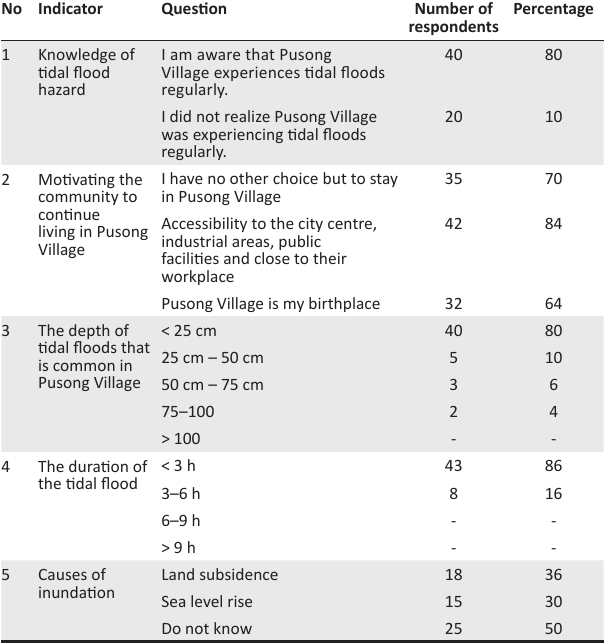
FIGURE 4: (a) The physical condition of building structures in Pusong Village; (b) Condition of community houses in Pusong Village. TABLE 1: Community perception of tidal flood hazard.